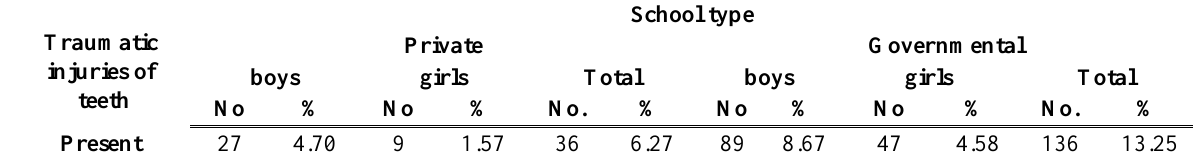
Table (2): Distribution of children with traumatic dental injuries by gender and school type.